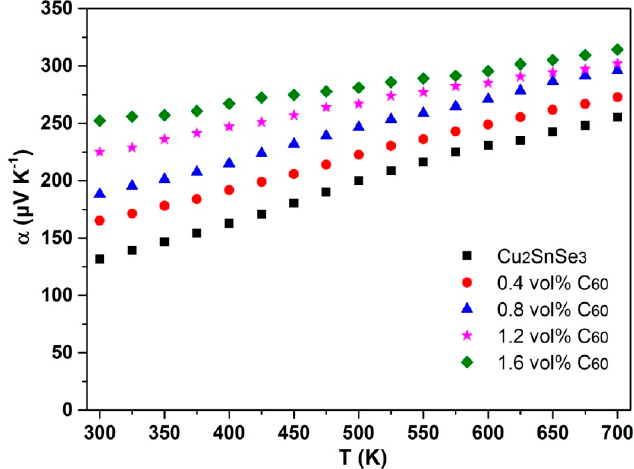
Figure 7. Temperature dependence of electrical conductivity ( σ ) of C 60 /Cu 2 SnSe 3 composites.